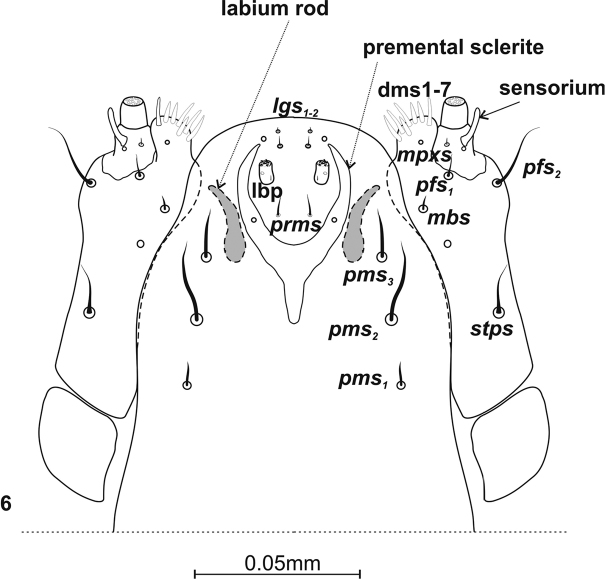
Labium and maxillae (L3) of Squamapion
atomarium.